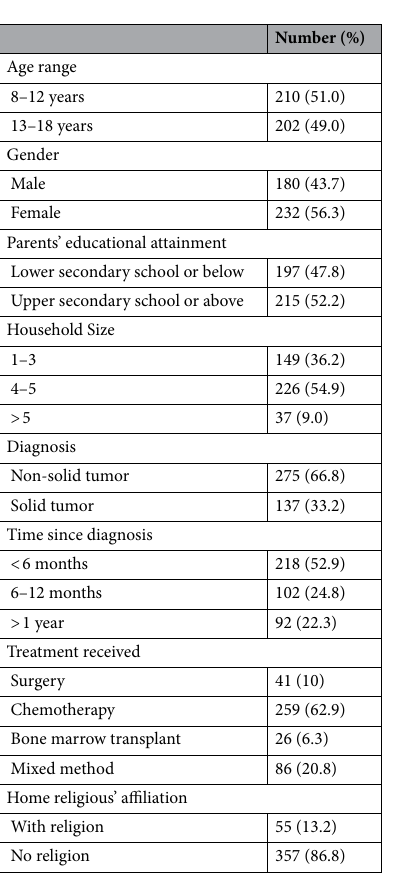
Table 1. Sociodemographic and clinical characteristics of the participants (N =